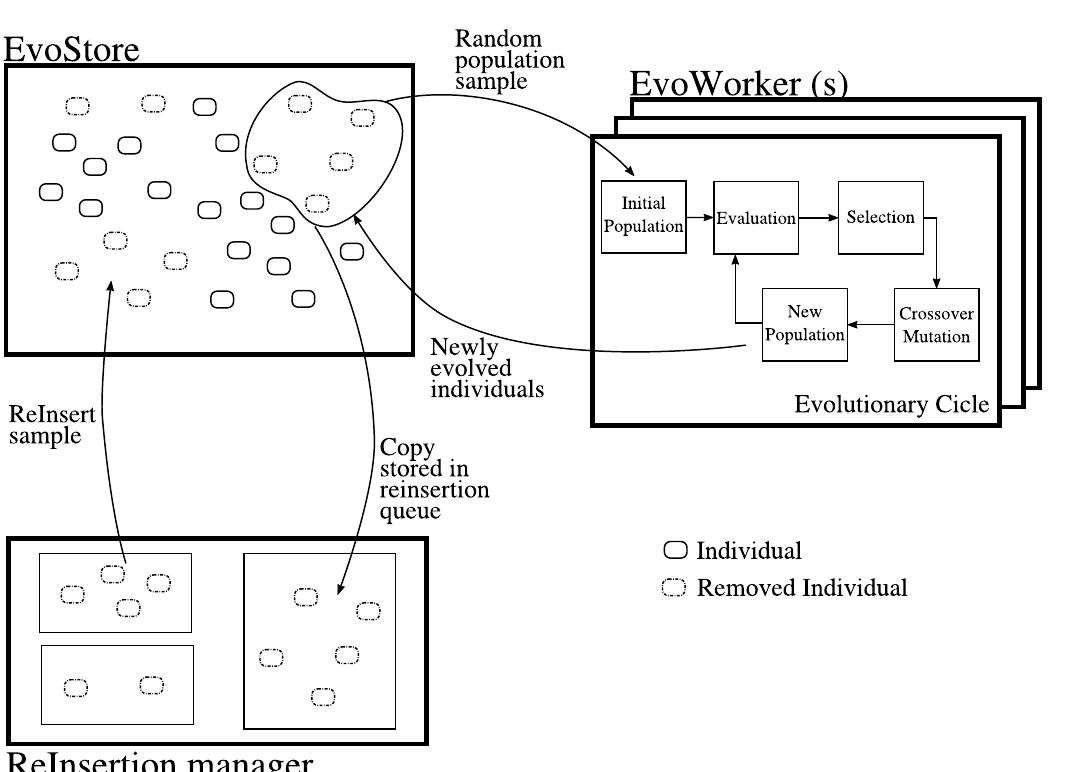
Figure 4. Main components and data flow within the EvoSpace